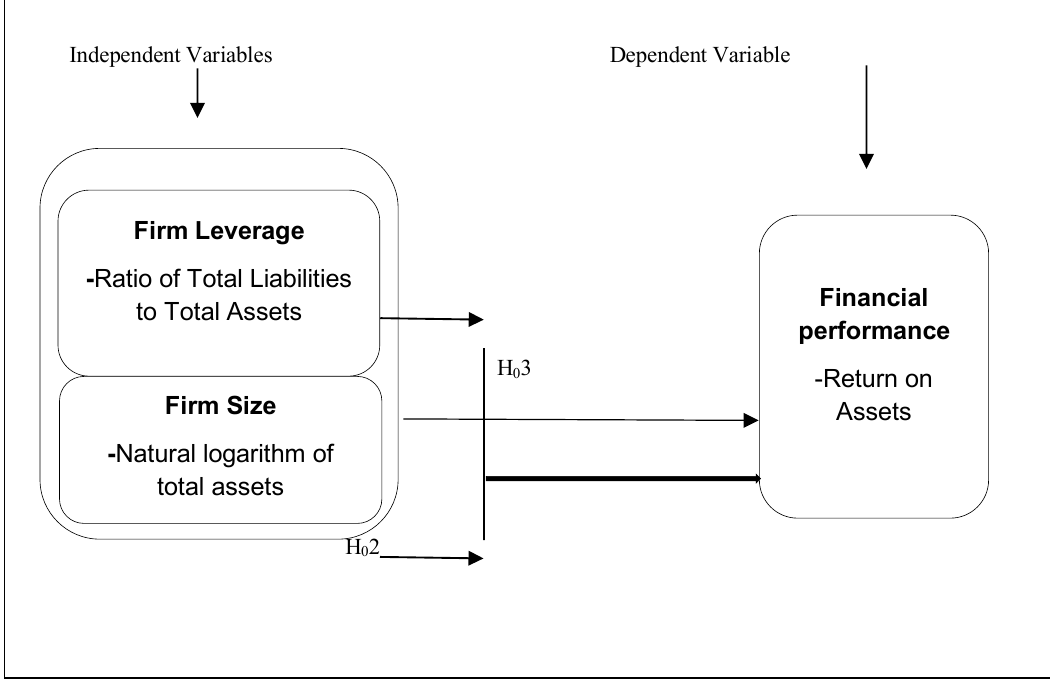
Figure 1: Conceptual framework Empirical